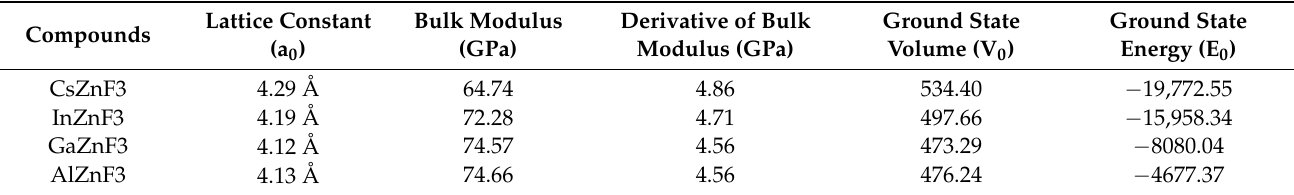
Table 1. Using GGA potential, calculated values of structural parameters include ground state lattice constant (a 0 ), ground state volume (V 0 ), ground-state energy (E 0 ), bulk modulus B(GPa), and the derivative of bulk modulus B (cid:48) of XZnF 3 compounds (X = Al, Cs, Ga, In).